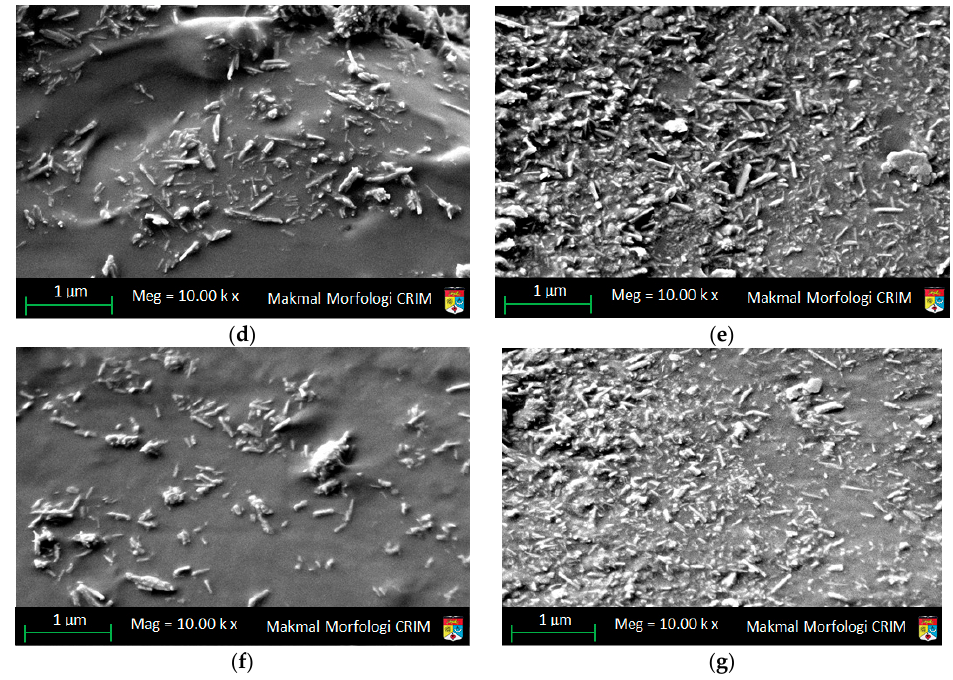
Figure 6. FESEM (10.00 k ×) of ( a ) TPU matrix; ( b ) 1 wt % u HNTs-TPU nanocomposites; ( c ) 3 wt % Figure 6. FESEM (10,000 × ) of ( a ) TPU matrix; ( b ) 1 wt % u HNTs-TPU nanocomposites; ( c ) 3 wt u HNTs-TPU nanocomposites; ( d ) 1 wt % a HNTs-TPU nanocomposites; ( e ) 3 wt % a HNTs-TPU